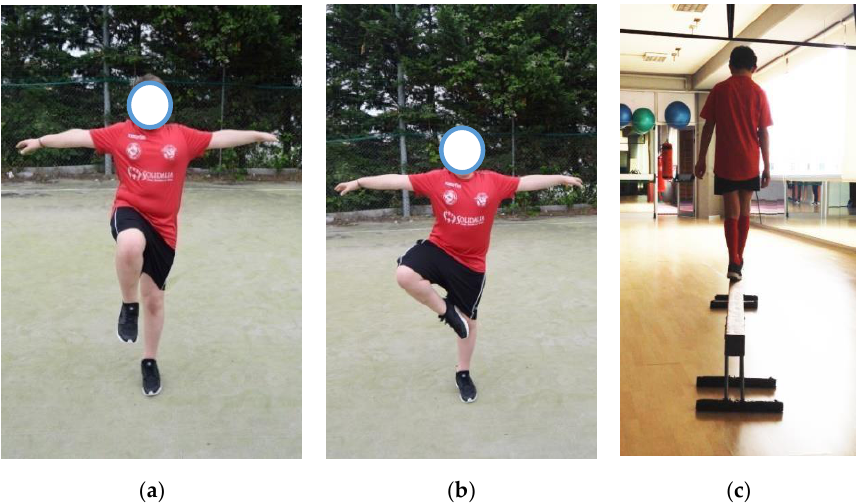
Figure 2. Evaluation tests. ( a ) single leg balance test (SLBT); ( b ) stork balance stand test (SBST); ( c ) balance beam walking test (BBWT).